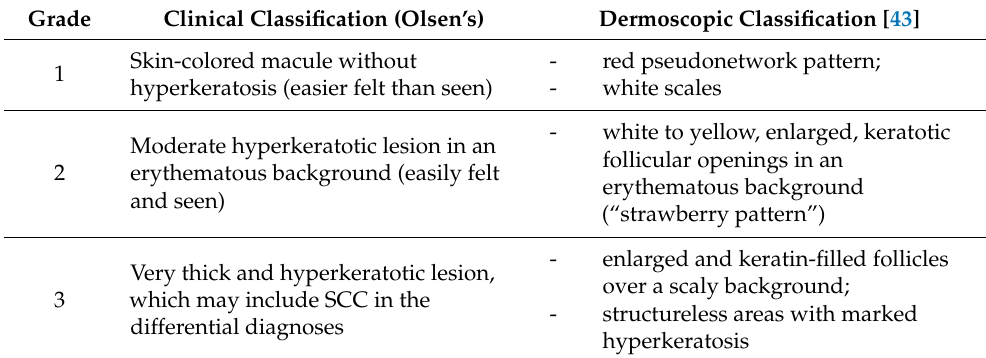
Table 2. Comparison between clinical and corresponding dermoscopic features of actinic keratoses according to grading.